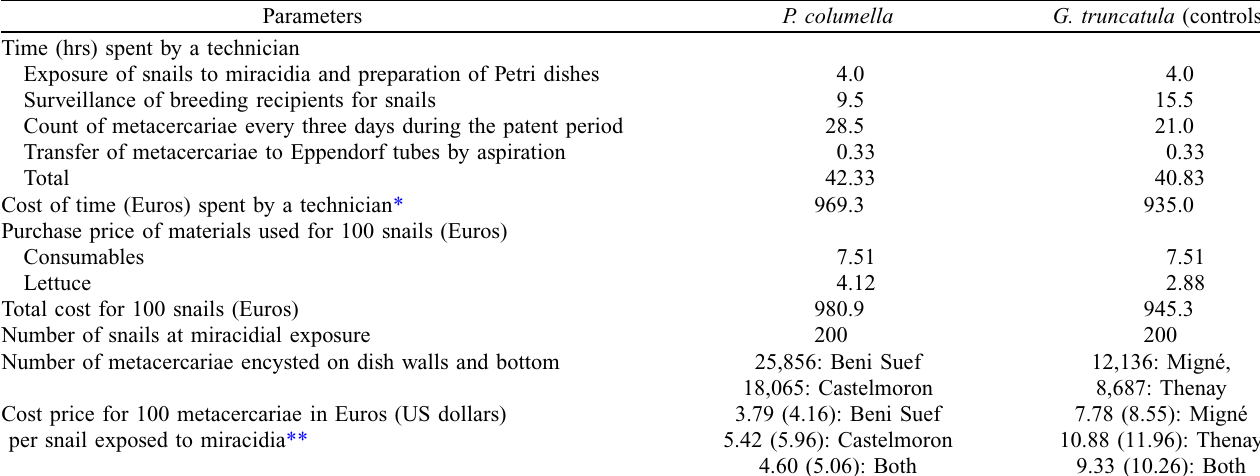
Table 3. Production costs for 100 metacercariae in Galba truncatula and Pseudosuccinea columella infected with Fasciola hepatica (five miracidia per snail at